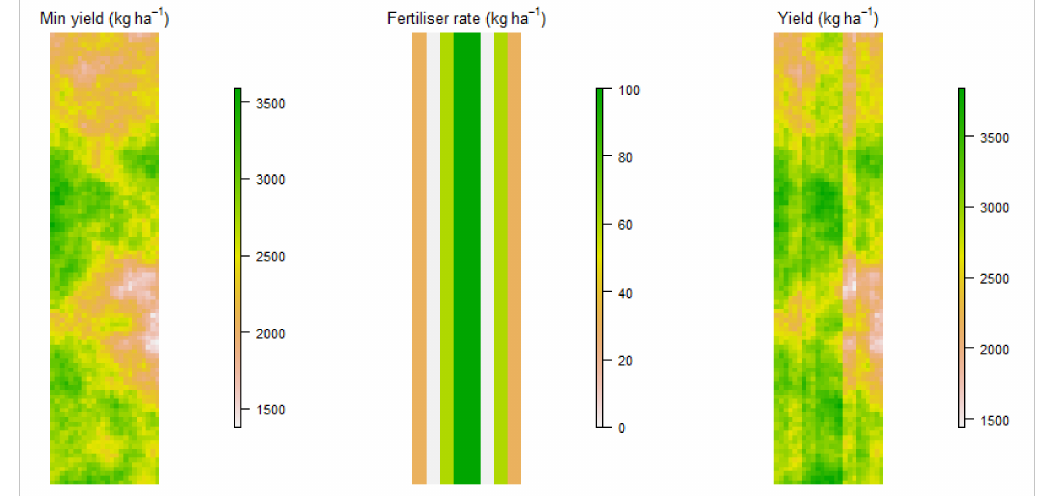
Figure 1. Simulation of global linear response.